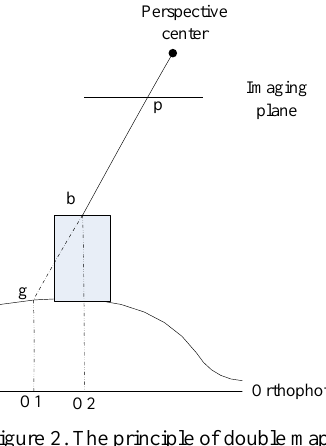
Figure 2. The principle of double mapping